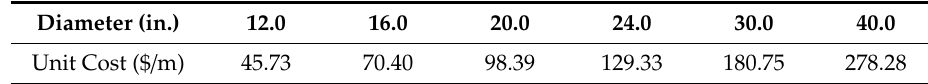
Table 1. Unit Costs of Hanoi